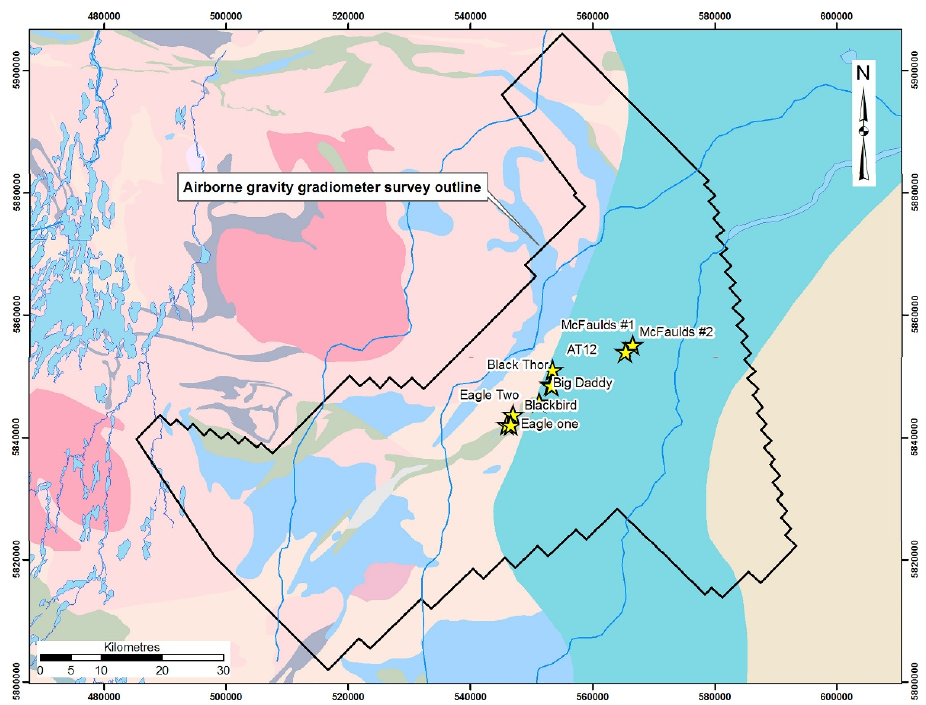
Figure 5. Airborne geophysical survey block in the McFaulds Lake region. airborne gravity gradiometry (AGG) and magnetic data were collected through the Fugro AGG and magnetic system (from [21]).